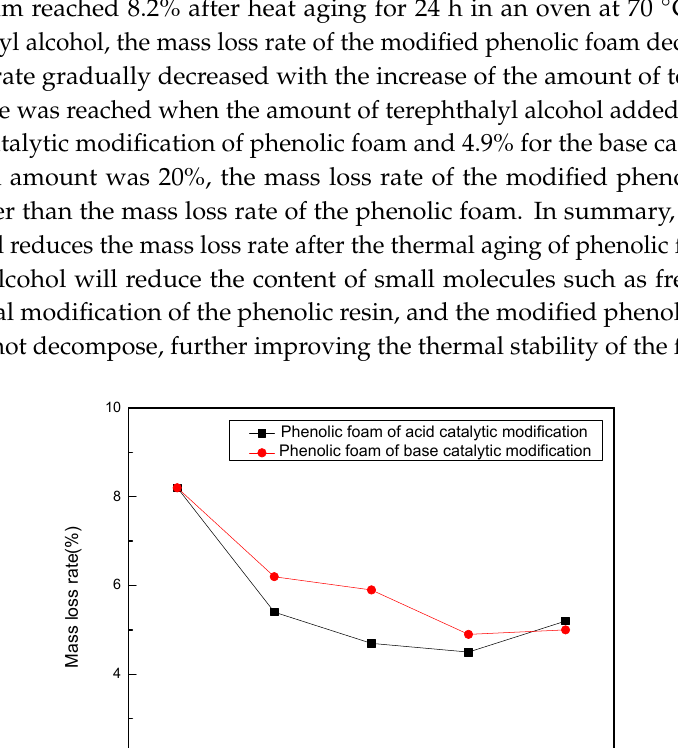
Figure 5. ( a ) Length dimension change rate of phenolic foam and modified phenolic foam; ( b ) width dimension change rate of phenolic foam and modified phenolic foam; ( c ) thickness dimension change rate of phenolic foam and modified phenolic foam.